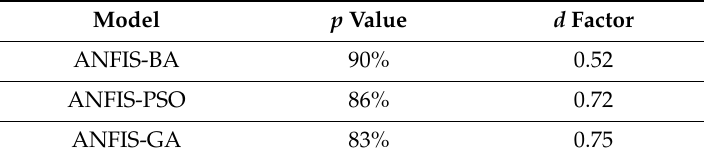
Table 7. The computation of uncertainty values for the di ff erent models.